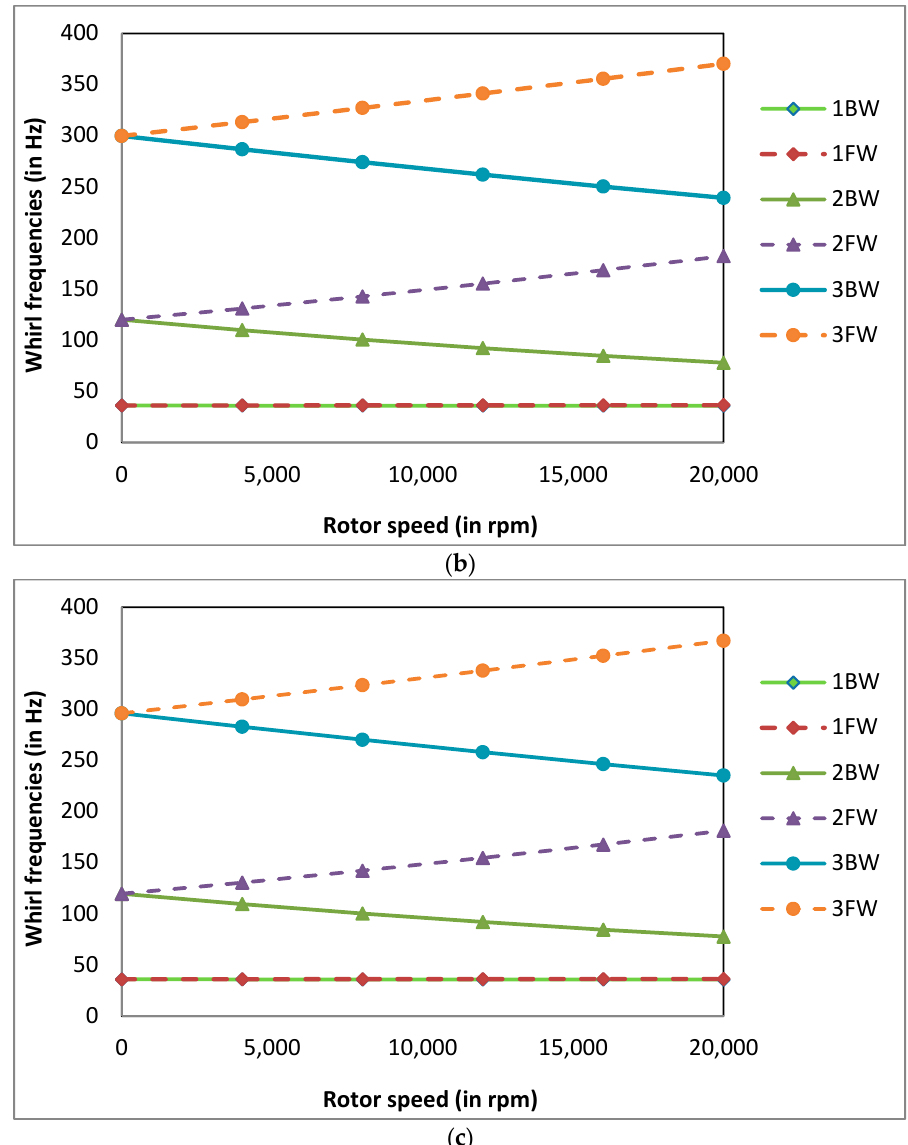
Figure 10. ( a ) Campbell diagram for the FG rotor-bearing system with a corrosion defect at X c /L = 0, d/R = 0.1, k = 0.5 and Δ T = 0 K; ( b ) Campbell diagram for the FG rotor-bearing system with a corrosion defect at X c /L = 0.1, d/R = 0.1, k= 0.5 and Δ T = 0 K; ( c ) Campbell diagram for the FG rotor-bearing system